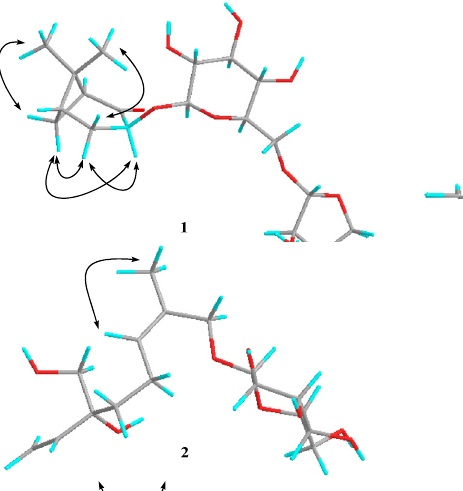
Figure 3. Main NOE correlations of compounds 1 – 3